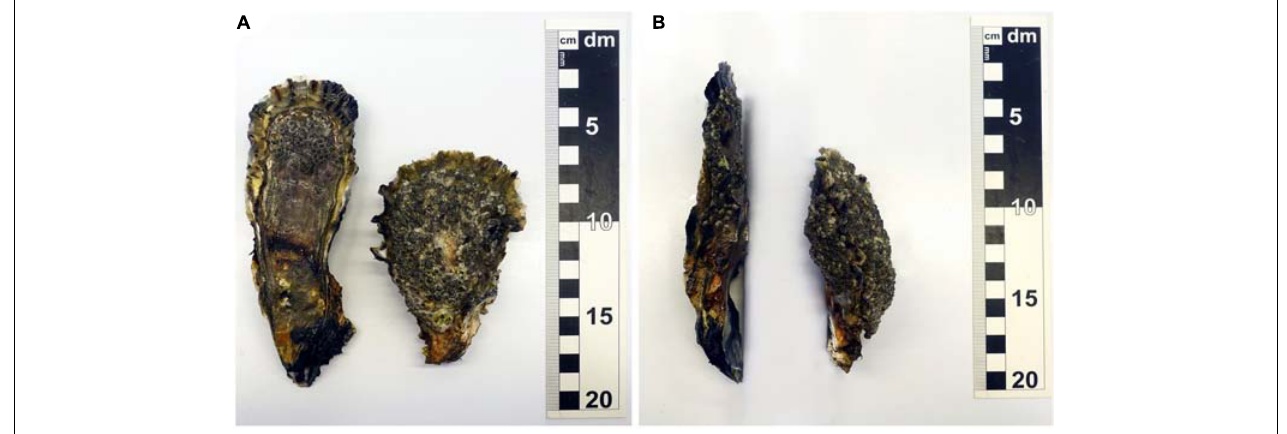
FIGURE 1 | Detailed view of two Magallana gigas individuals illustrating the variability of the oyster shell morphology of mature individuals. (A) View along the long axis of the oyster shells. (B) View along the short axis of the oyster